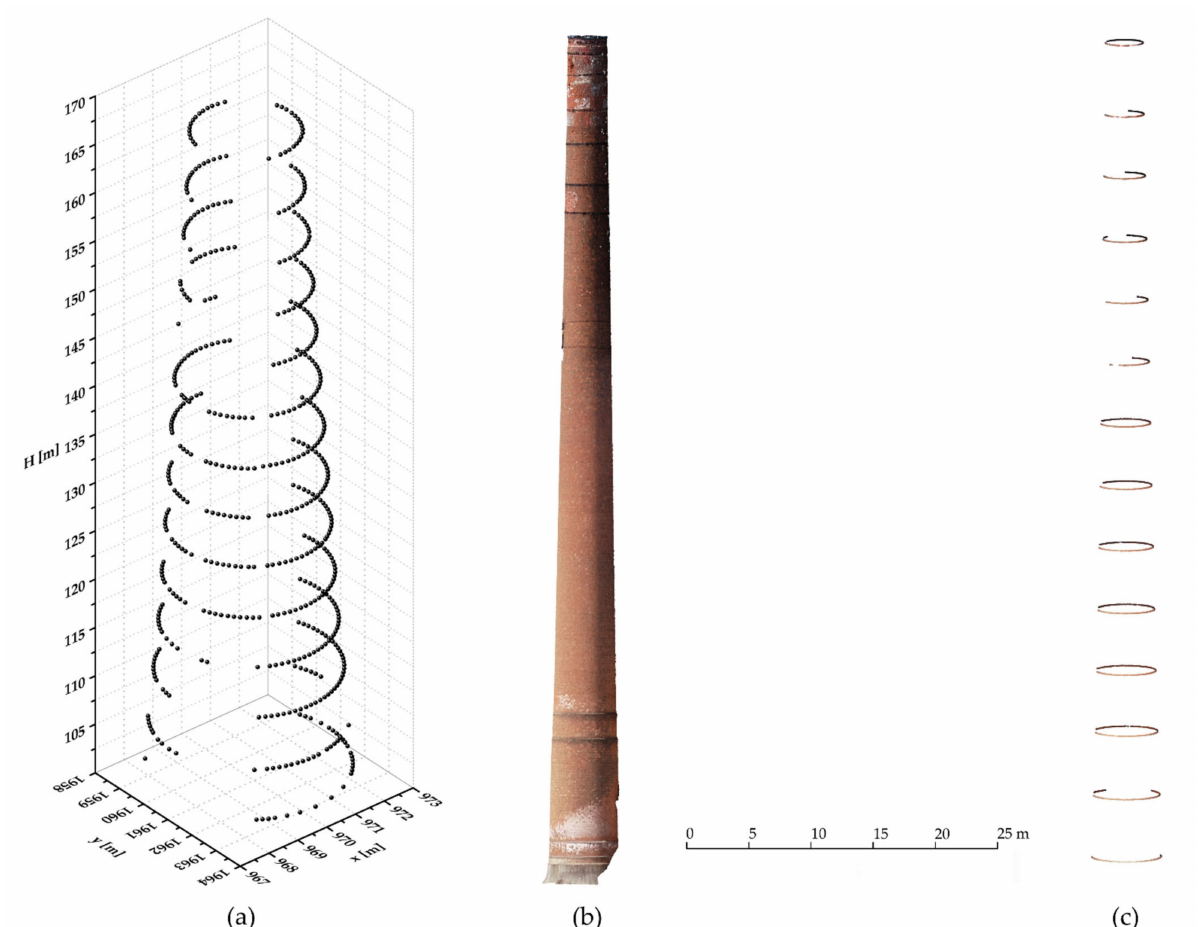
Figure 6. Total Station (TS) and Unmanned Aerial System (UAS) data processing results; ( a ) 3D visualization of the TS-based data set of the chimney; ( b ) chimney full point cloud (PC) generated by photogrammetric processing; ( c ) chimney PC cross-sectional segmentation